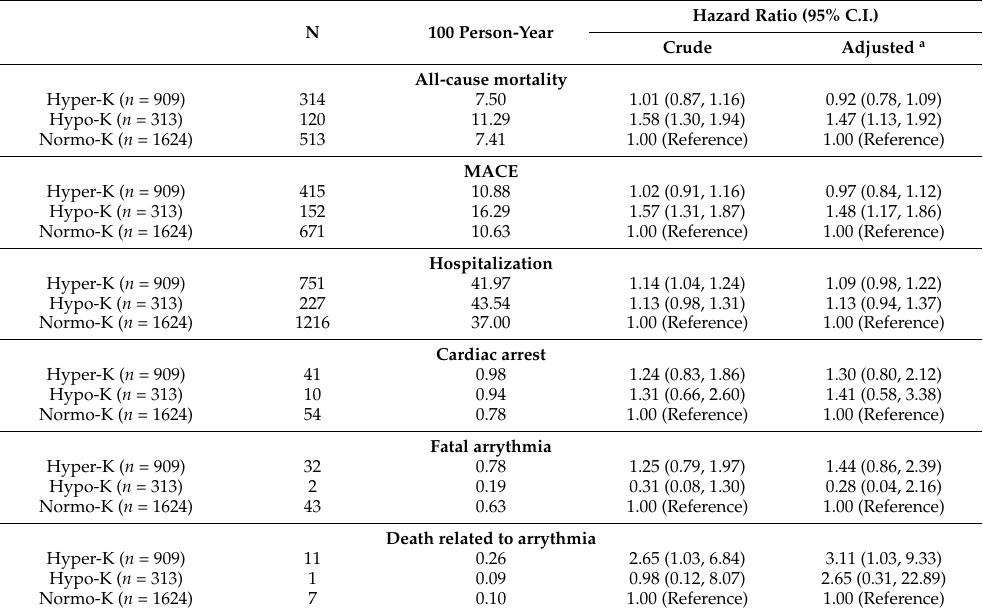
To estimate the hazard ratio, the Normo-K group was used as the reference level. a Adjustments: age, gender, dialysis vintage, index year, body mass index (BMI), albumin, C-reactive protein (CRP), urea reduction ratio (URR), serum calcium, serum phosphorus (centralized by subtracting mean), serum phosphorus squared (squared after centralized), hemoglobin, HD treatment time, Charlson Comorbidity Index (CCI), and history of comorbidities: heart failure, diabetes, cardiovascular comorbidities, myocardial infarction, other acute ischemic heart diseases, atherosclerotic heart disease of native coronary artery, chronic ischemic heart disease, stroke, unstable angina, angina pectoris unspecified, heart failure, and